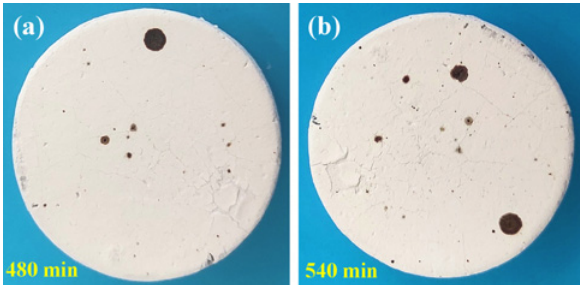
Fig. 11 Changes in the morphology of tri-layer Yb 2 Si 2 O 7 /SM/SiC coating-coated C f /SiC samples in the burner rig test at 1673 K with the scouring time: (a) 480 min; (b) 540 min.